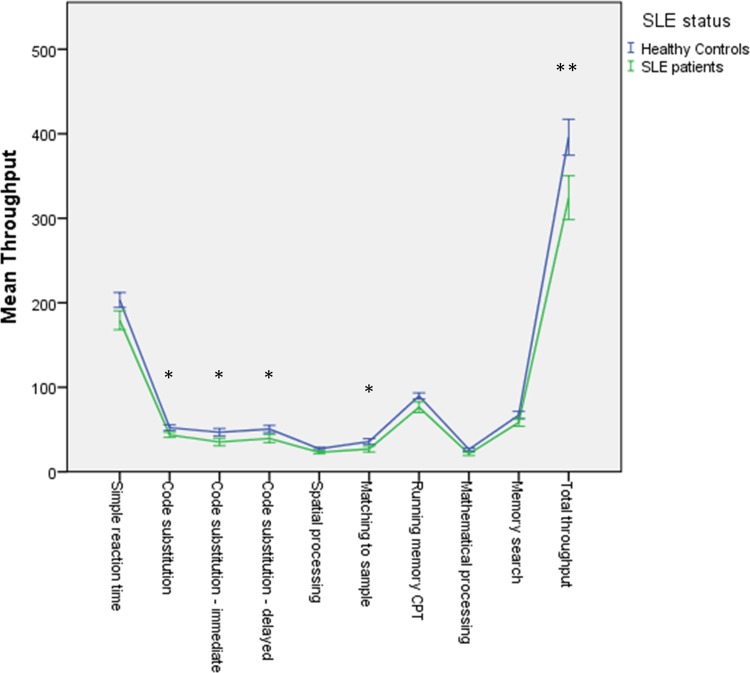
Mean throughput scores in SLE patients and HCs.Higher scores represent better performance. The individual test data points for each group are connected for illustration purposes only. *P<0.05; **P<0.01.